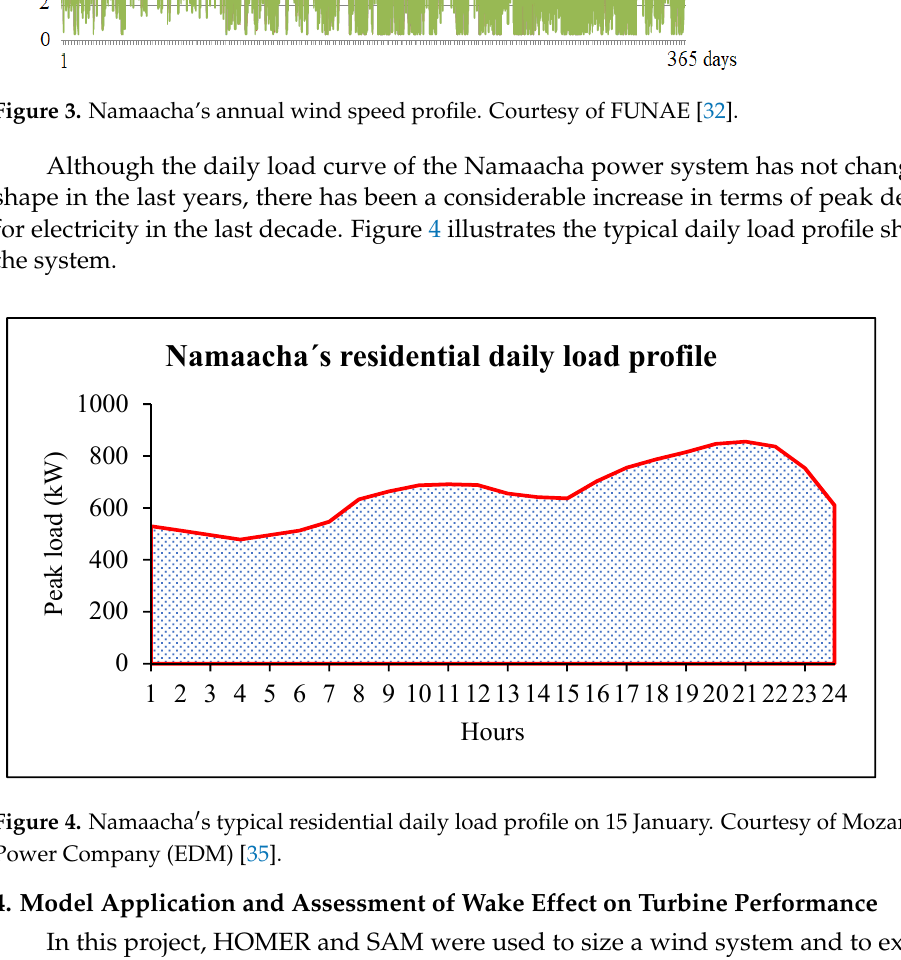
Figure 3. Namaacha’s annual wind speed profile. Courtesy of FUNAE [32].